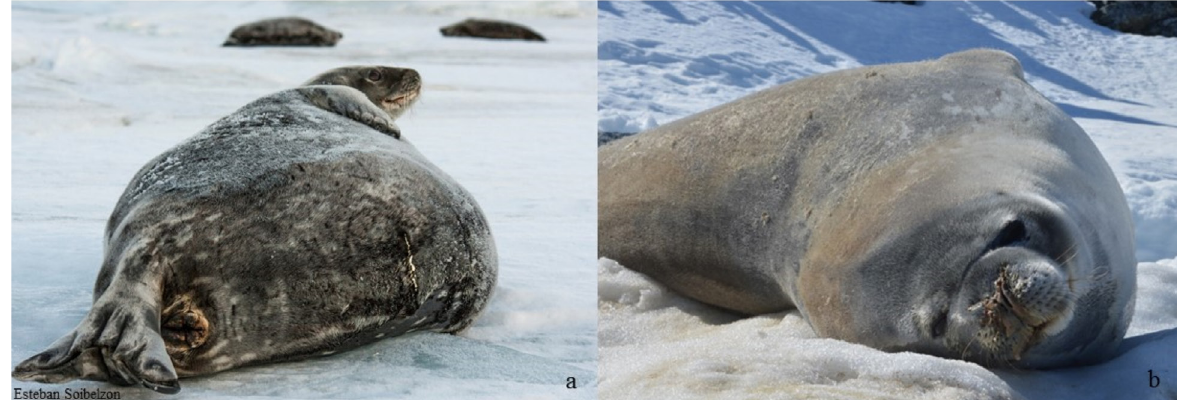
Figure 2. a) Weddell seal on Marambio/Seymour Island during the reproductive season. b) Weddell seal in the Danco Coast during the molting